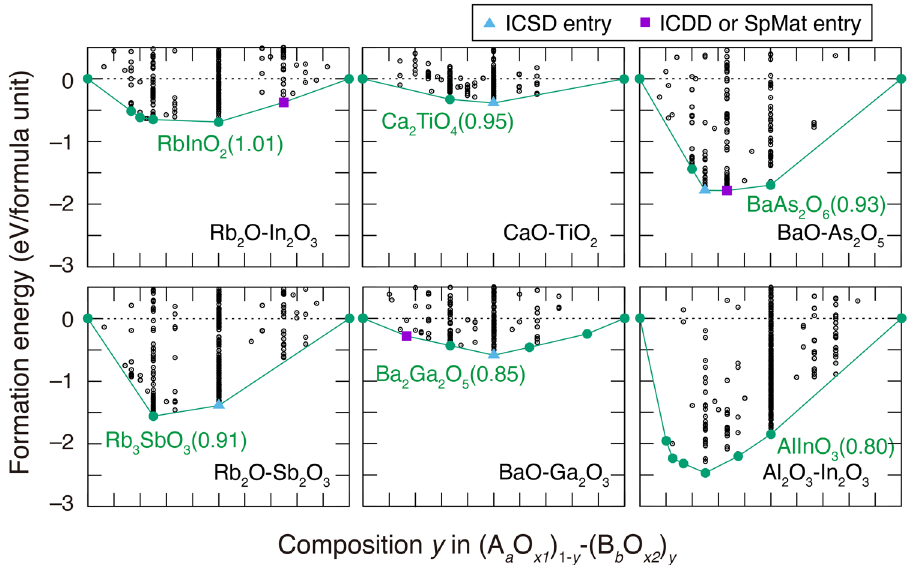
Fig. 6 The convex hull of the formation energy by the DFT calculations for pseudo-binary-oxide systems containing candidate CRCs. Closed circles (green) denote compounds on the convex hull. Closed triangles (blue) and squares (violet) denote CRCs registered in ICSD and ICDD-PDF + SpMat, respectively. Candidate compositions are given with recommendation scores in parentheses. Adopted from ref. 14 with modi fi